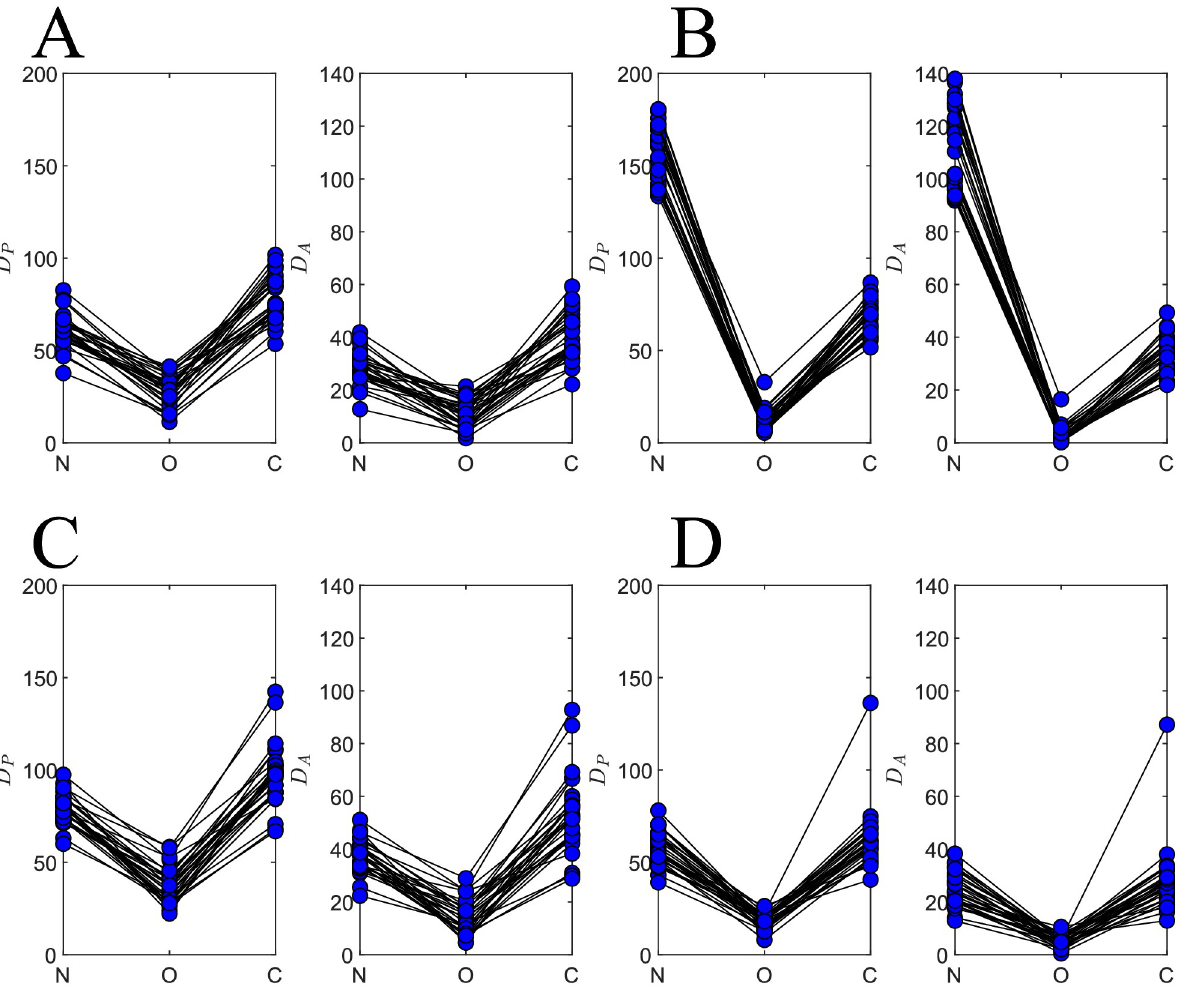
Fig 5. PSPM improves qualitative agreement between output activity signals and reference activity signals (Methods). Subplots ( A )-( D ) show single neuron activity signals of network outputs for a representative trial. In particular, these are the activity signals for neuron 1 in this trial. If r 1 ( t ), n 1 ( t ), o 1 ( t ), c 1 ( t ) represent the spike trains of the first neuron in the reference, naive, optimized, and control networks respectively then the activity signals a ( r 1 ( t ), t ), a ( n 1 ( t ), t ), a ( o 1 ( t ), t ), a ( c 1 ( t ), t ) are plotted in ( A ), ( B ), ( C ), and ( D ) respectively (Methods). Transitioning from the naive state to the optimized state there is clear improvement in the agreement with the reference activity signal. Similarly, the post-optimization signal a ( o 1 ( t ), t ) exhibits greater agreement with the reference signal a ( r 1 ( t ), t ) than does the control total activity signal A ð C ; t Þ with the reference signal. The fact that ( A ) and ( C ) show closest agreement indicates successful learning due to PSPM. Total activity signals are plotted in ( E )-( H ).If the total activity signals for the reference spike trains R , naive spike trains N , optimized spike trains O , and control spike trains C are represented by A ð R ; t Þ , A ð N ; t Þ , A ð O ; t Þ , A ð C ; t Þ , then these are respectively plotted under labels ( E ), ( F ), ( C ), and ( D ) (Methods).